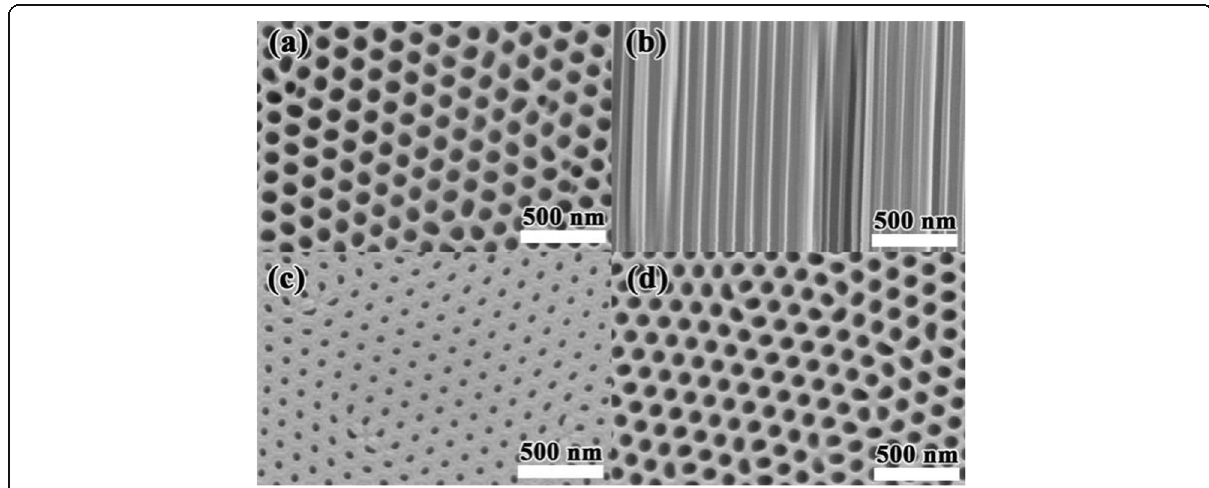
Fig. 3 SEM images of a the surface, b cross-sectional view of the AAO membrane, and the bottom-view of the AAO membrane after etching the barrier Al layer for c 10 min, d 20